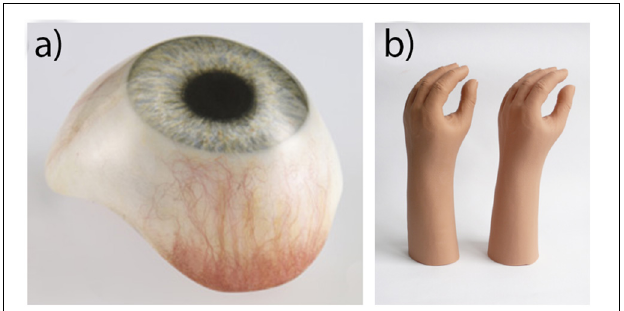
FIGURE 3 | (a) Acrylic prosthetic eye. Reproduced with permission from Erickson Labs Northwest (Northwest_Eye_Design, 2019). (b) PVC glove (left) and silicone glove (right), illustrating an equivalent aesthetic appearance. Reproduced with permission from Sage (Smit et al., 2014).